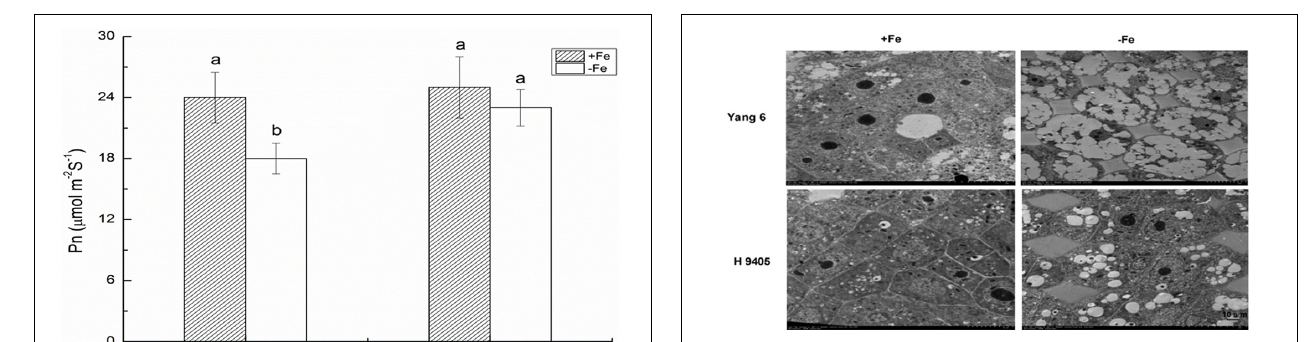
FIGURE 7 | Effects of iron deficiency on root tip cell